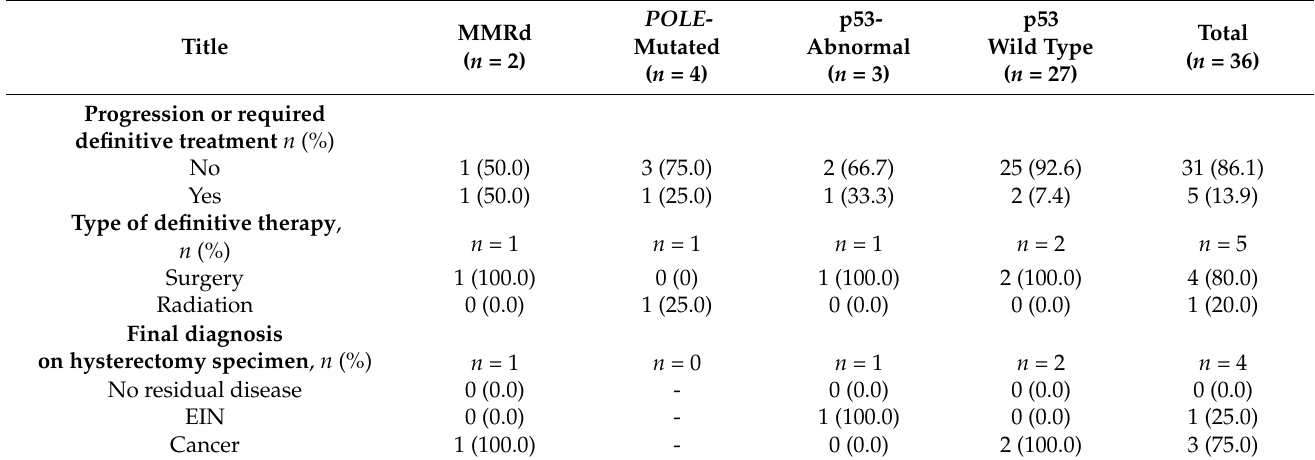
Table 5. Molecular characterization of patients with endometrioid endometrial intraepithelial neoplasia ( n = 37) and